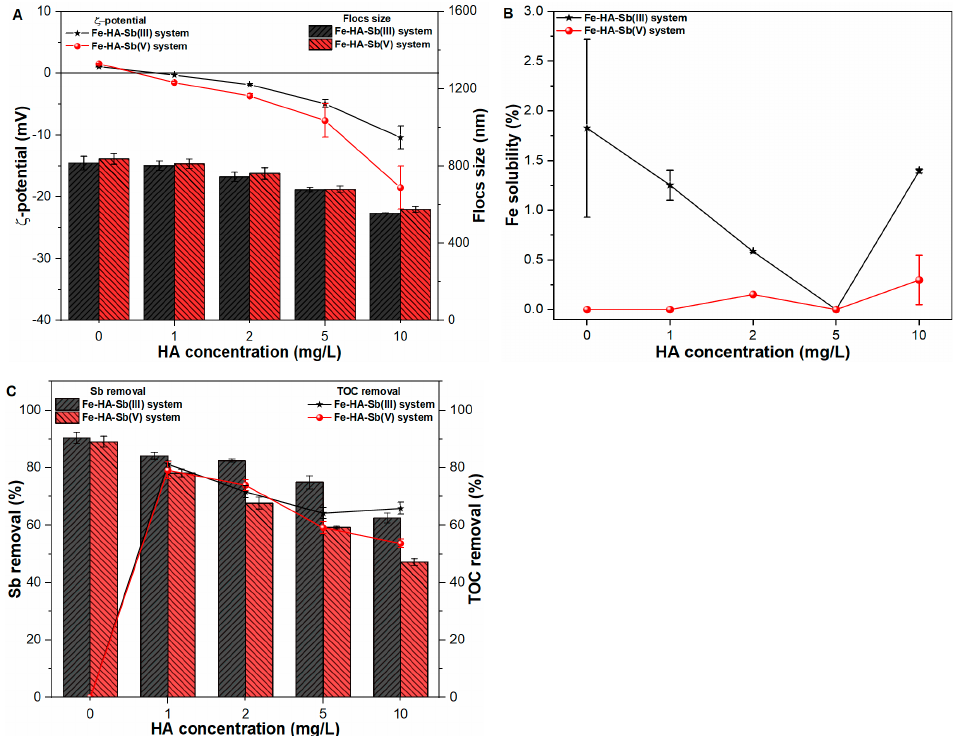
Figure 6. Influence of HA concentration on ( A ) zeta potential (mV) and size (nm) of freshly formed Fe flocs; ( B ) Fe solubility (%) and; ( C ) Sb removal (%) and TOC removal (%) in Sb(III, V)